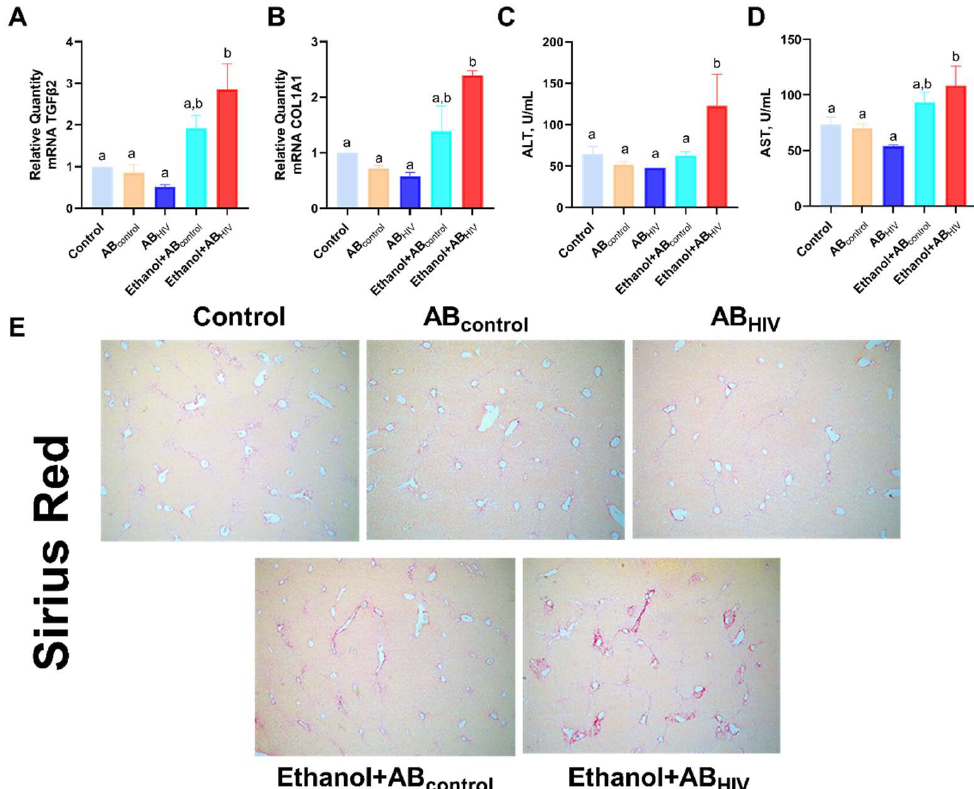
Figure 11. Ethanol potentiates collagen deposition and liver damage in the liver of mice treated with HIV-containing apoptotic bodies: RT-PCR analysis of mouse tissues for ( A ) TGF β 2 mRNA and ( B ) COL1A1 mRNA. ( C ) ALT levels (U/mL); ( D ) AST levels (U/mL). ( E ) Histological examination of mouse liver tissues using Sirius red staining. Bars marked with the same letter are not significantly different. Bars with different letters are sig-nificantly different from each other ( p ≤